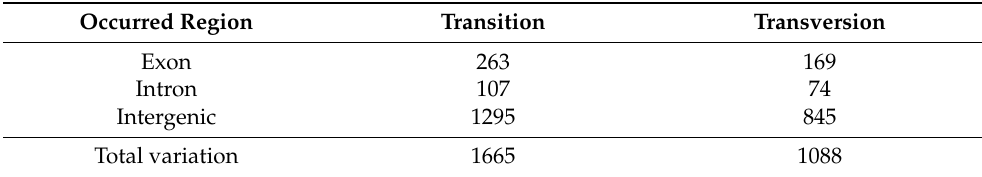
Figure 6. Analysis of substitutions which have been consistently identified in T 1 and T 3 transgenic Chinese cabbage plants. Table 2. Analysis of substitutions which have commonly occurred in T 1 and T 3 transgenic Chinese cabbage plants.